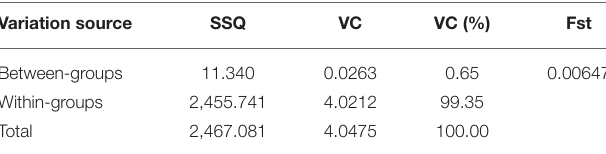
TABLE 2 | Summary of the AMOVA results for the population structure